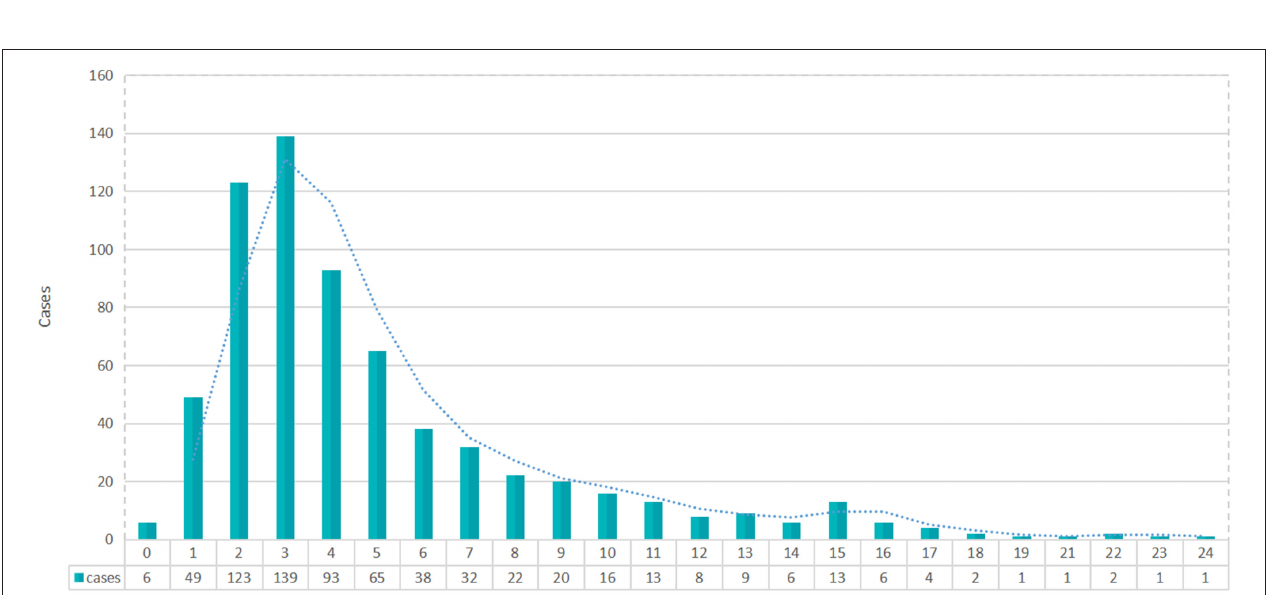
FIGURE 6 | Distribution of confirmed time after confirmed cases leave the epidemic area.